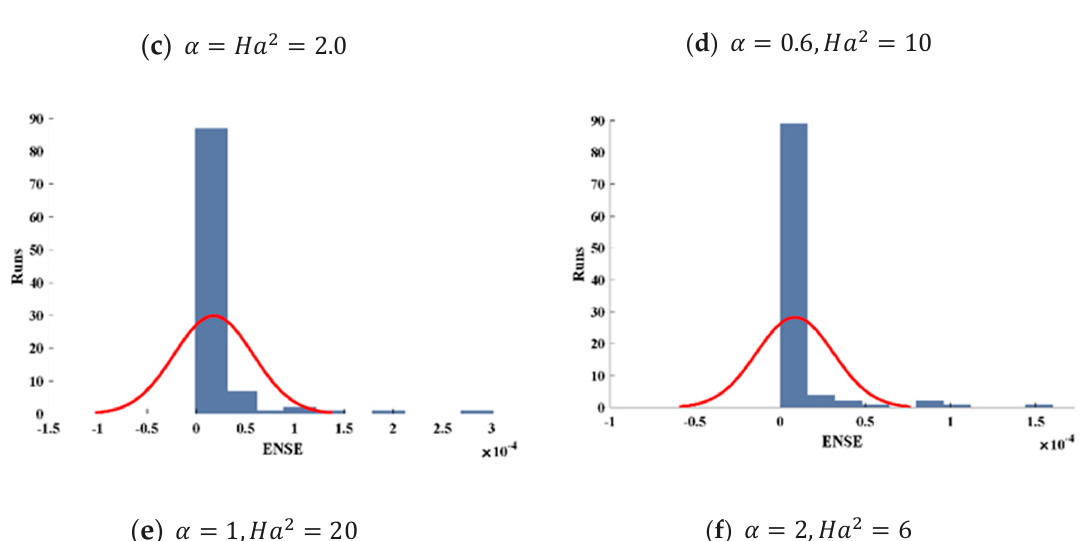
( e ) 𝛼 = 1, 𝐻𝑎 (cid:2870) = 20 ( f ) 𝛼 = 2, 𝐻𝑎 (cid:2870) = 6